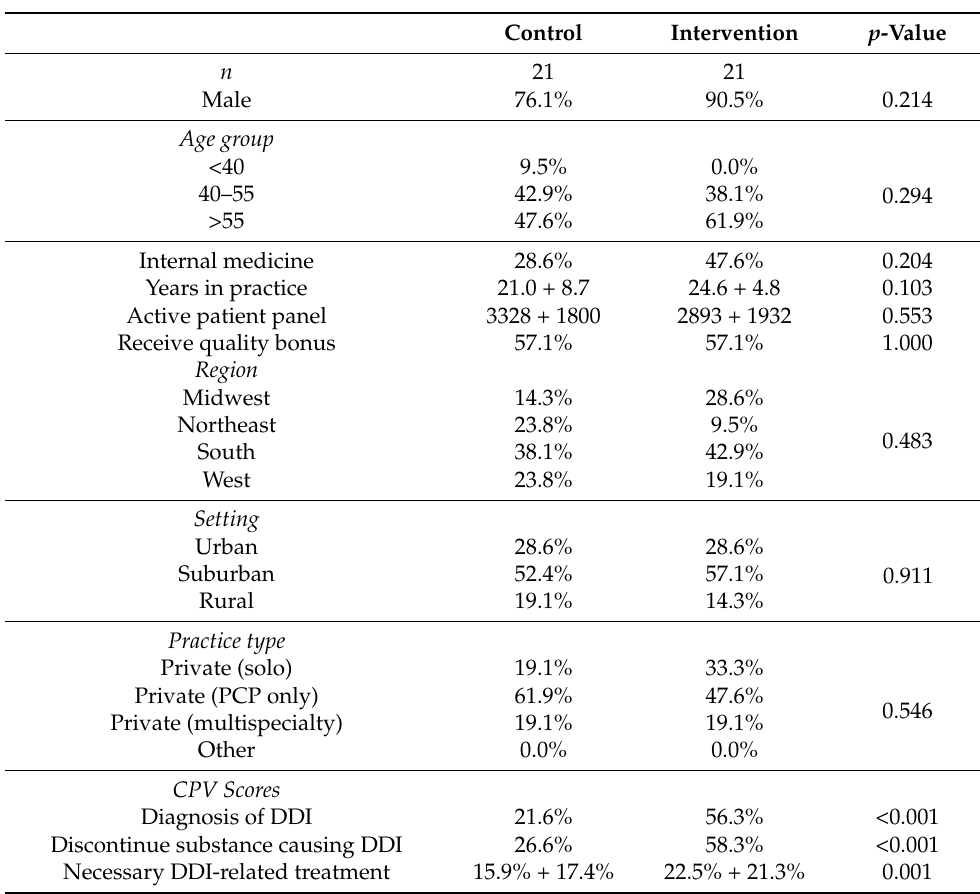
Table 1. Physician baseline